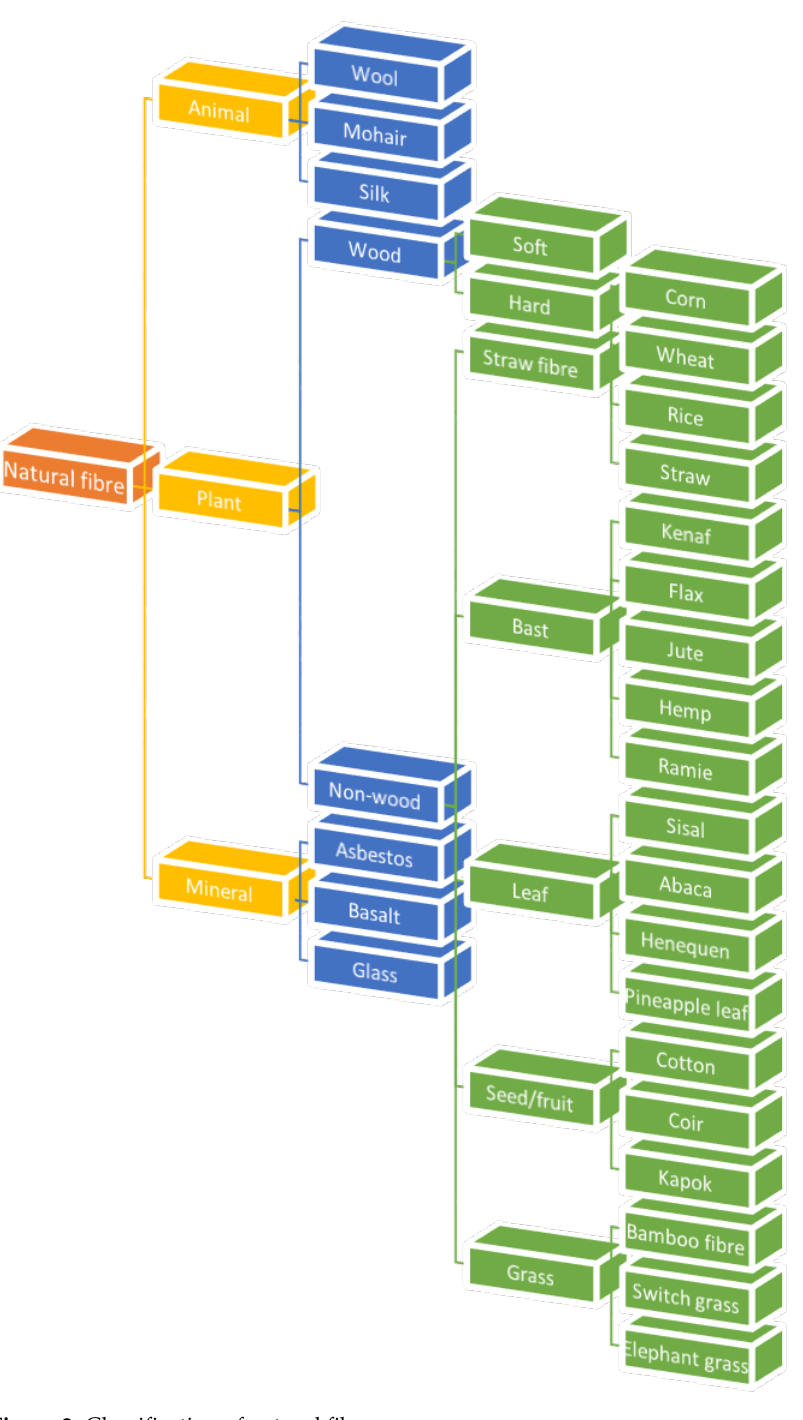
Figure 2. Classification of natural fibres.